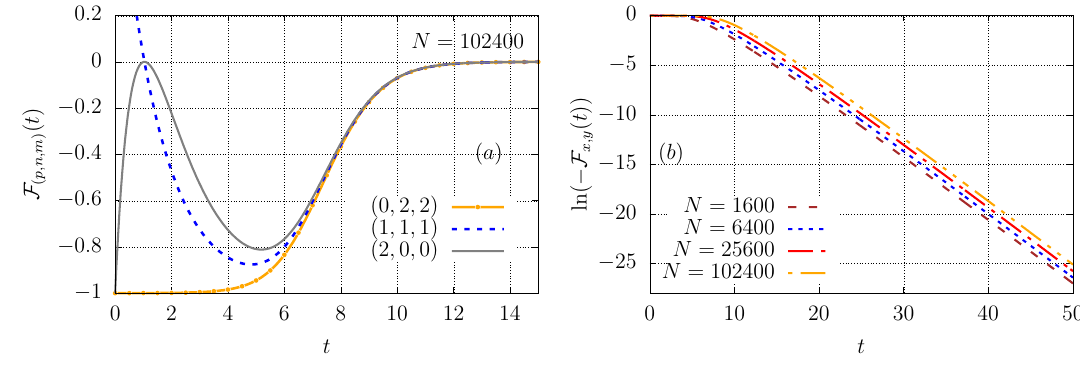
Figure 7 . Sub(cid:12)gure ( a ): time evolution of di(cid:11)erent OTOCs corresponding to initial strings of Majorana operators with the same length. Each curve is labeled by three integer numbers, according to the convention of eq. (3.34). We see that in this case all the OTOCs quickly approach the same curve. Sub(cid:12)gure ( b ): large-time behavior of the logarithm of the OTOC The initial behavior in eq. (4.4), together (cid:12)gure 5( b ), suggests that a data